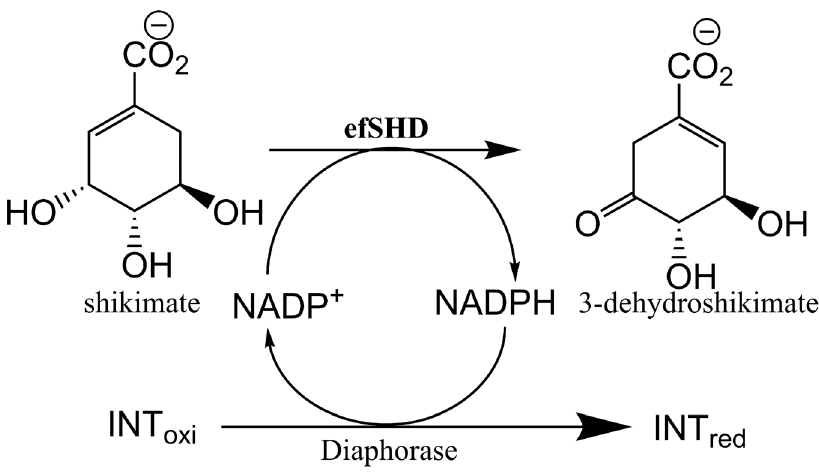
Figure 4. efSHD-diaphorase coupled-enzyme assay.